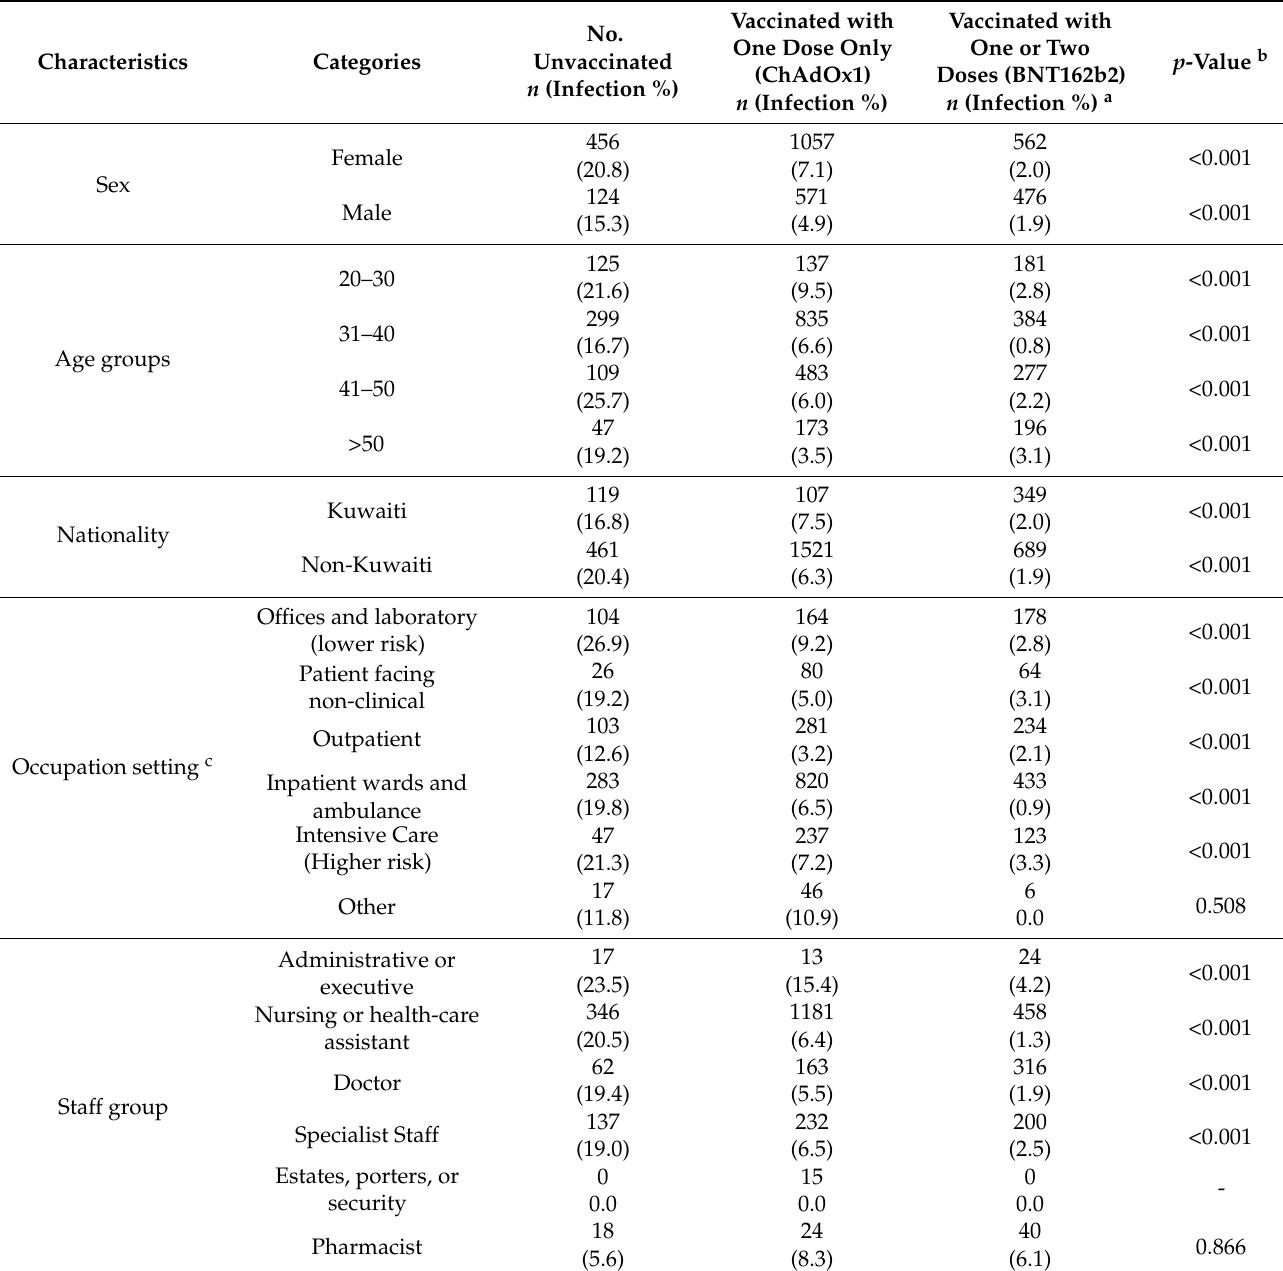
Table 2. Prevalence of SARS-CoV-2 PCR–confirmed infections in HCWs ( n = 3246) received BNT162b2 or ChAdOx1 COVID-19 vaccines at a major secondary hospital in Kuwait, 24 December 2020–15 June 2021.